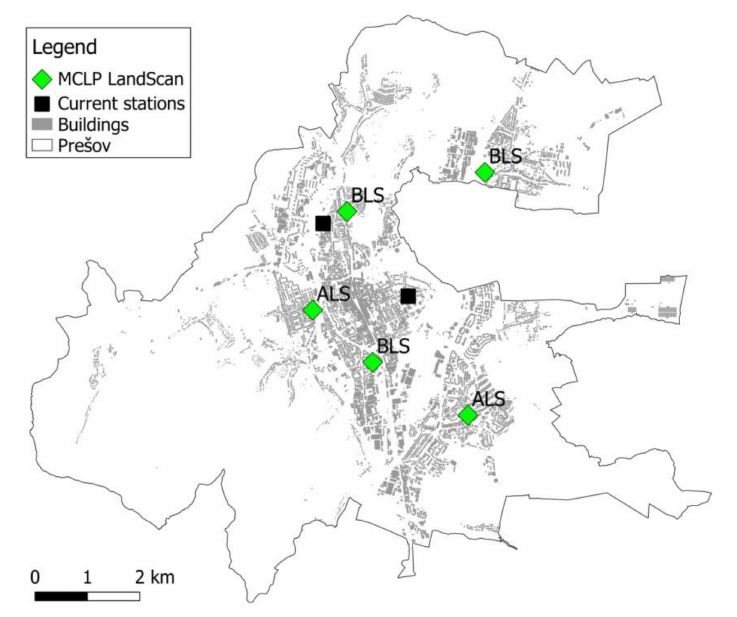
Figure 5. Ambulance locations using the MCLP model with the LandScan demand